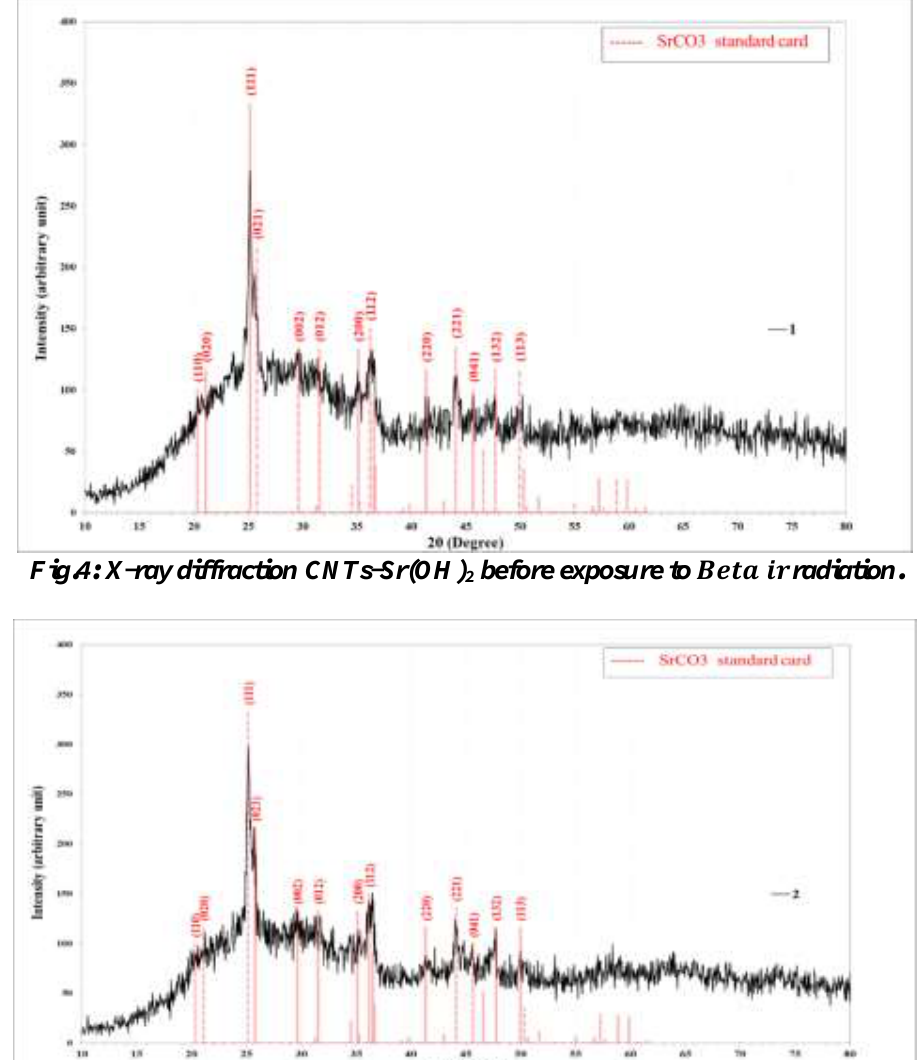
after exposure to1hr Beta 2